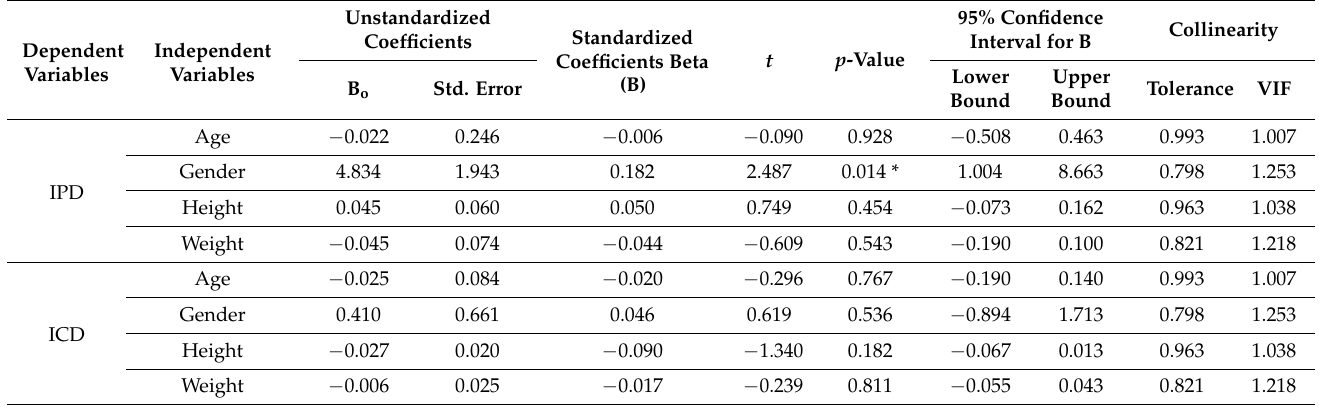
Table 11. The linear regression analysis of age, gender, height, and weight with mid horizontal facial third proportion ( n =